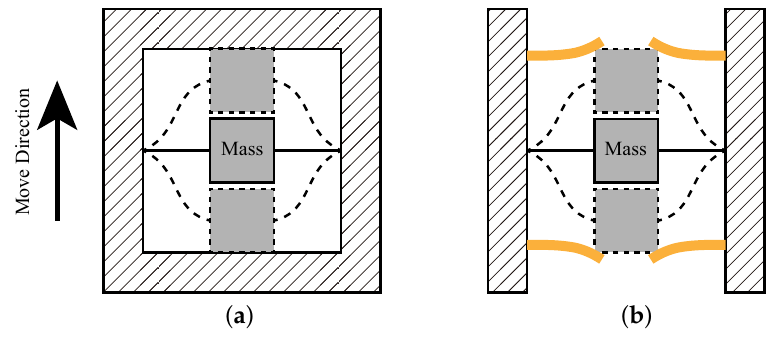
Figure 4. The two types of stoppers: ( a ) The solid stopper. ( b ) The elastic stopper.